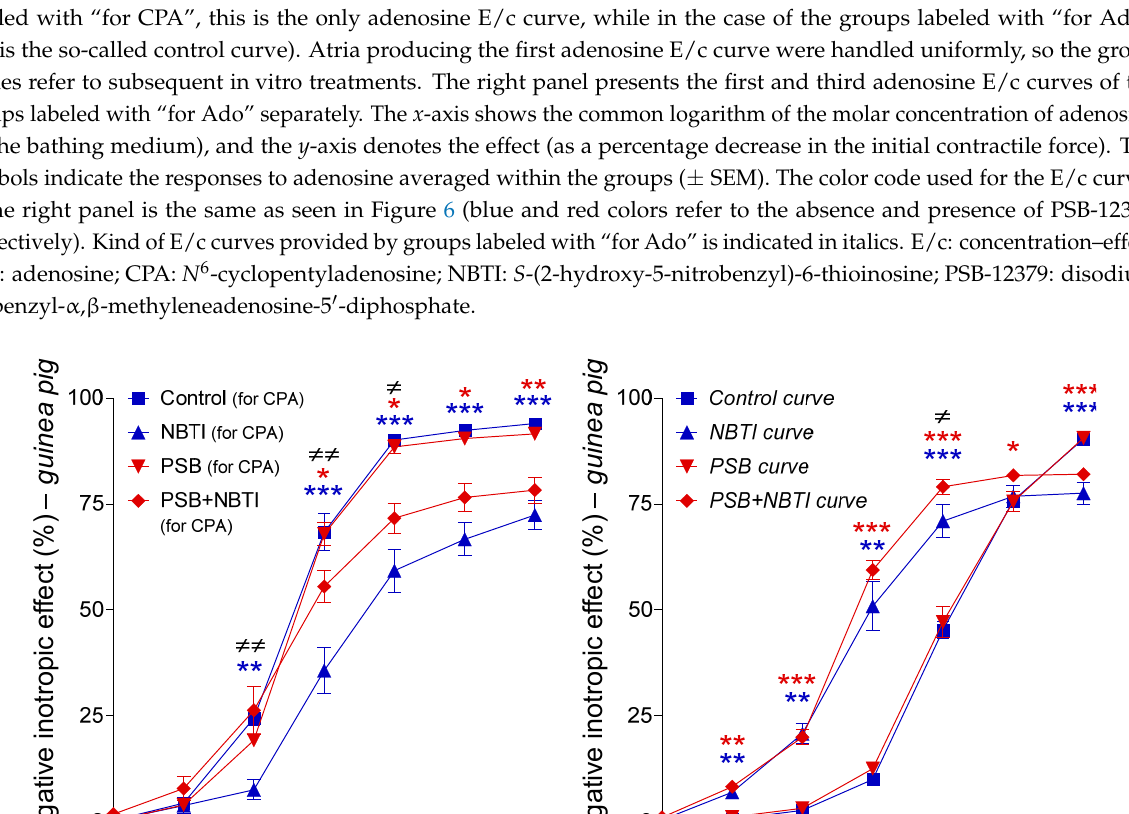
Figure 6. The direct negative inotropic effect of CPA ( left panel ) and adenosine ( right panel ) in the isolated guinea pig left atrium, in the absence and presence of 10 μ M NBTI and 3 μ M PSB-12379 (in all combinations). Since neither the two control curves nor the two PSB+NBTI curves differed significantly from each other (see the right panel of Figure 5), these curve pairs were pooled (as seen in the right panel here). The x -axis shows the common logarithm of the molar concentration of the given agonist (in the bathing medium), and the y -axis indicates the effect (as a percentage decrease in the initial contractile force). The symbols indicate the responses to the agonists averaged within the groups (± SEM). The blue and red E/c curves refer to the absence and presence of PSB-12379, respectively. The kind of E/c curves provided by groups labeled with “for Ado” is indicated in italics. E/c: concentration–effect; Ado: adenosine; CPA: N 6 -cyclopentyladenosine; PSB-12379: disodium N 6 -benzyl- α , β -methyleneadenosine-5’-diphosphate; NBTI: S -(2-hydroxy-5-nitrobenzyl)-6-thioinosine; blue asterisks: comparison of the Control (for CPA) group with the NBTI (for CPA) group (left panel), or comparison of the pooled control curve with the NBTI-treated curve (right panel); red asterisks: comparison of the Control (for CPA) group with the PSB+NBTI (for CPA) group (left panel) or comparison of the pooled control curve with the pooled PSB+NBTI-treated curve (right panel); ≠ : comparison of the NBTI (for CPA) group with the PSB+NBTI (for CPA) group ( left panel ), or comparison of the NBTI-treated curve with the pooled PSB+NBTI-treated curve ( right panel ); the number of marks means the level of statistical significance (one mark: p < 0.05, two marks: p < 0.01, three marks: p < 0.001).